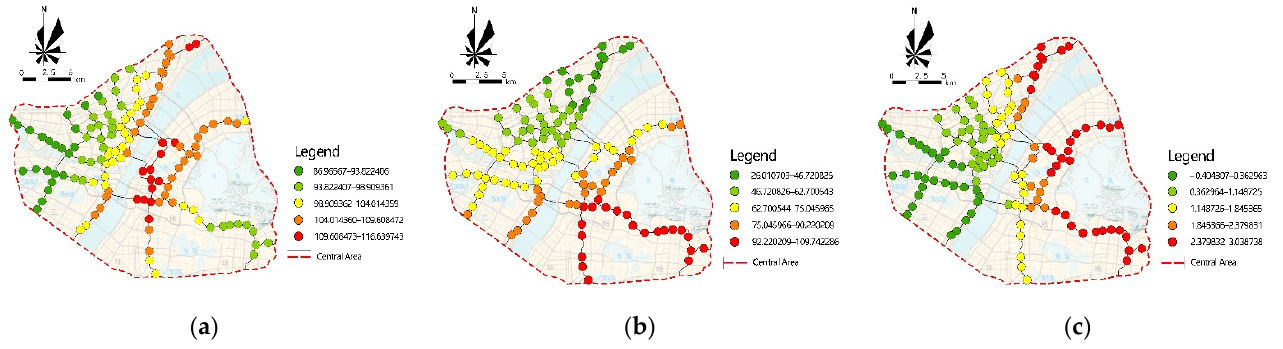
Figure 9. The spatial variation in the impact of significant variables on school commuting flow. ( a ) whether station is a transfer station regression coefficient; ( b ) floor area ratio regression coefficient; ( c ) bus stop density regression coefficient.